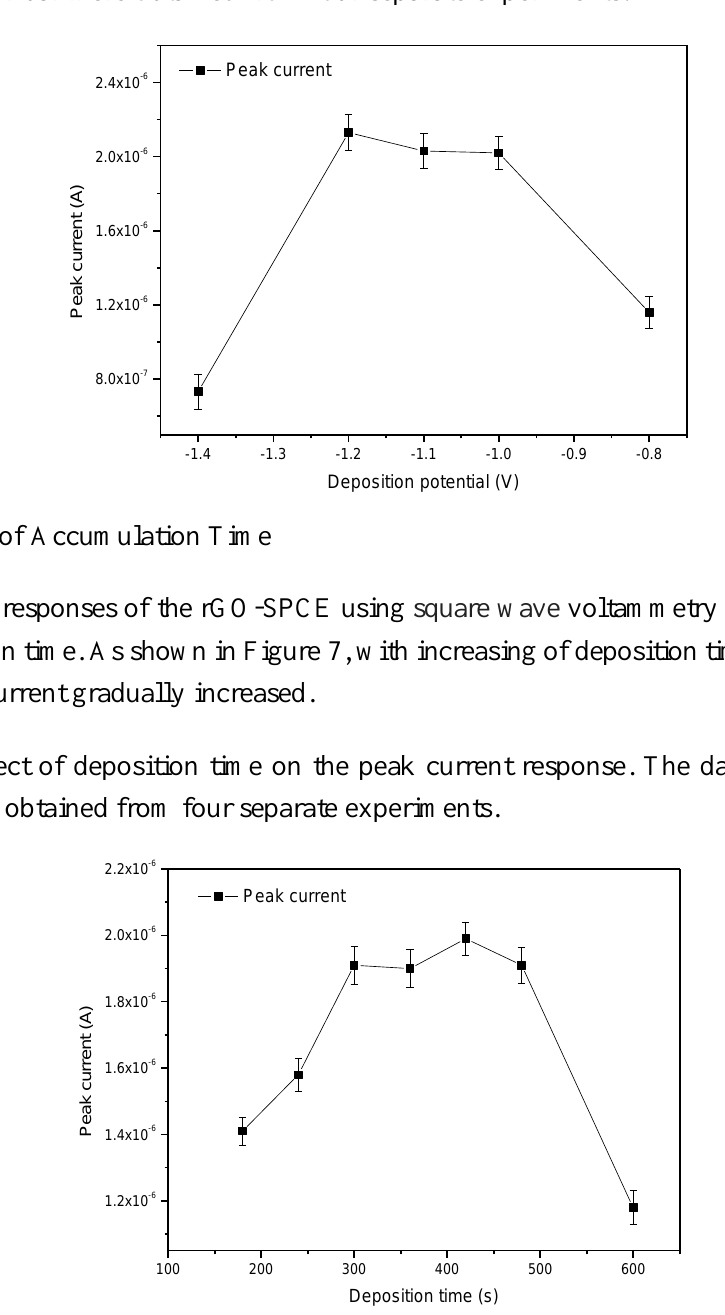
Figure 6. Effect of deposition potential on the peak current response. The data for respective error bar were obtained from four separate experiments.